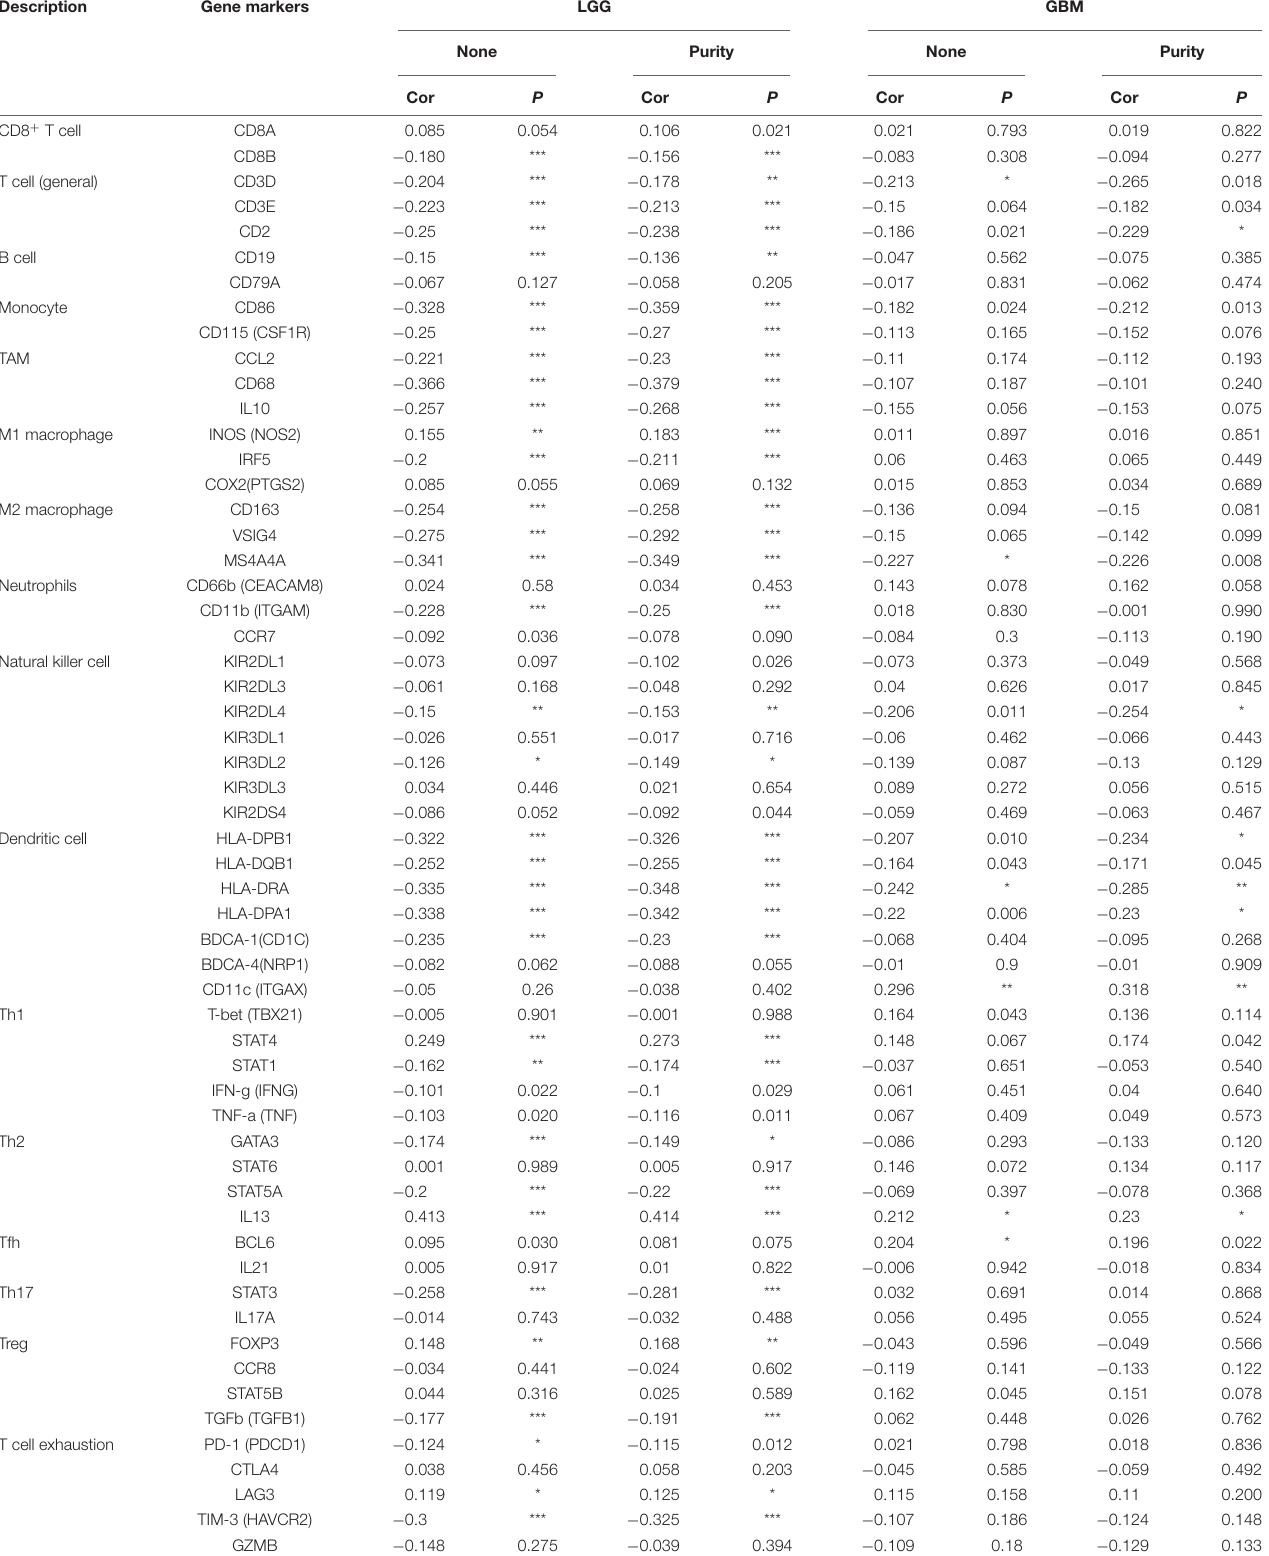
TABLE 5 | Correlation analysis between MEG3 and relate genes and markers of immune cells in TIMER.